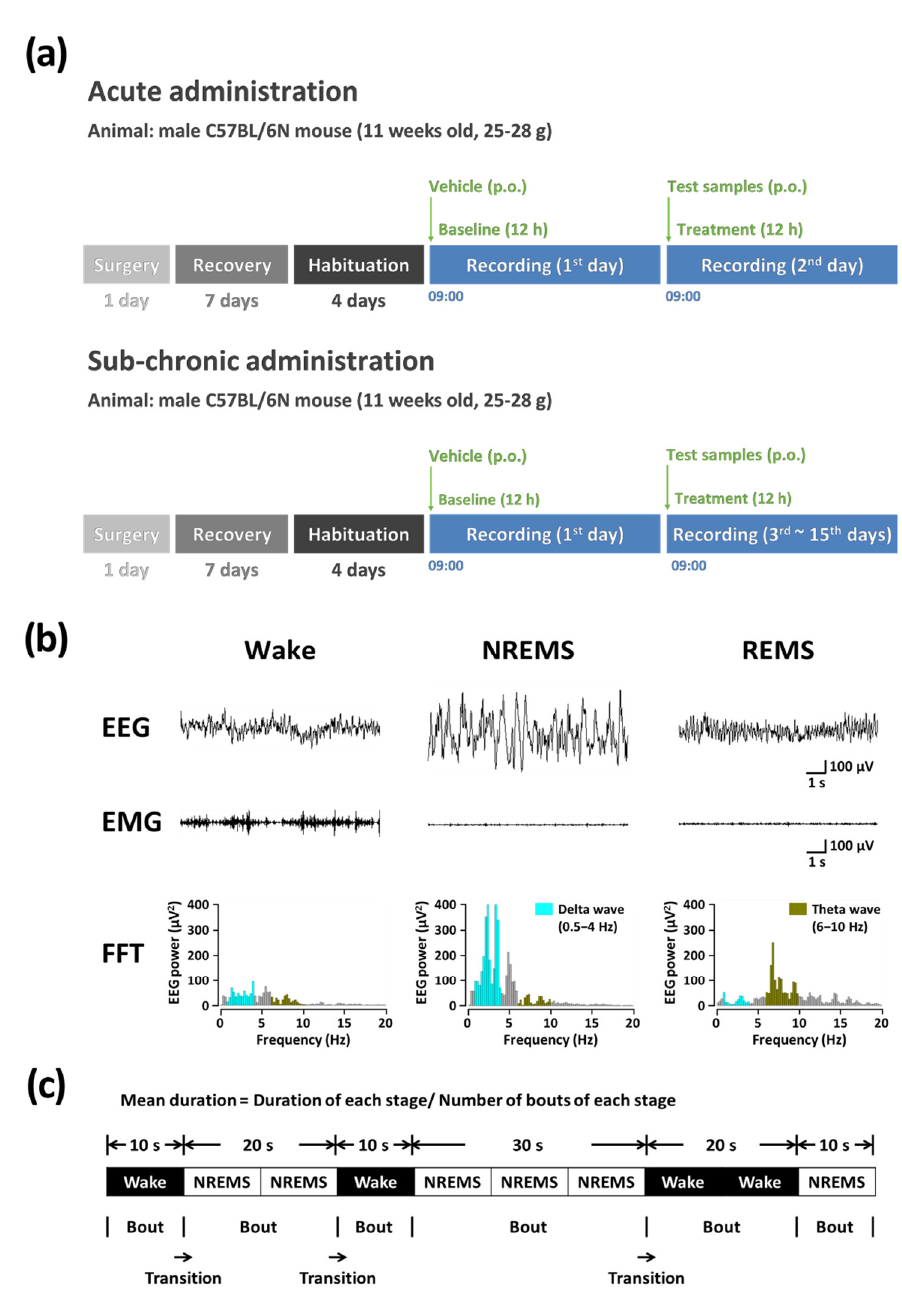
Figure 1. ( a ) Experimental procedure of acute and sub-chronic (15 days) administration for polysomnographic recordings. ( b ) Typical EEG, EMG, and FFT spectra in C57BL/6N mice. ( c ) Definition of sleep-wake episodes. EEG, electroencephalogram; EMG, electromyogram; FFT, fast Fourier transform; NREMS, non-rapid eye movement sleep; p.o., per os injection; REMS, rapid eye movement sleep; Wake, wakefulness.